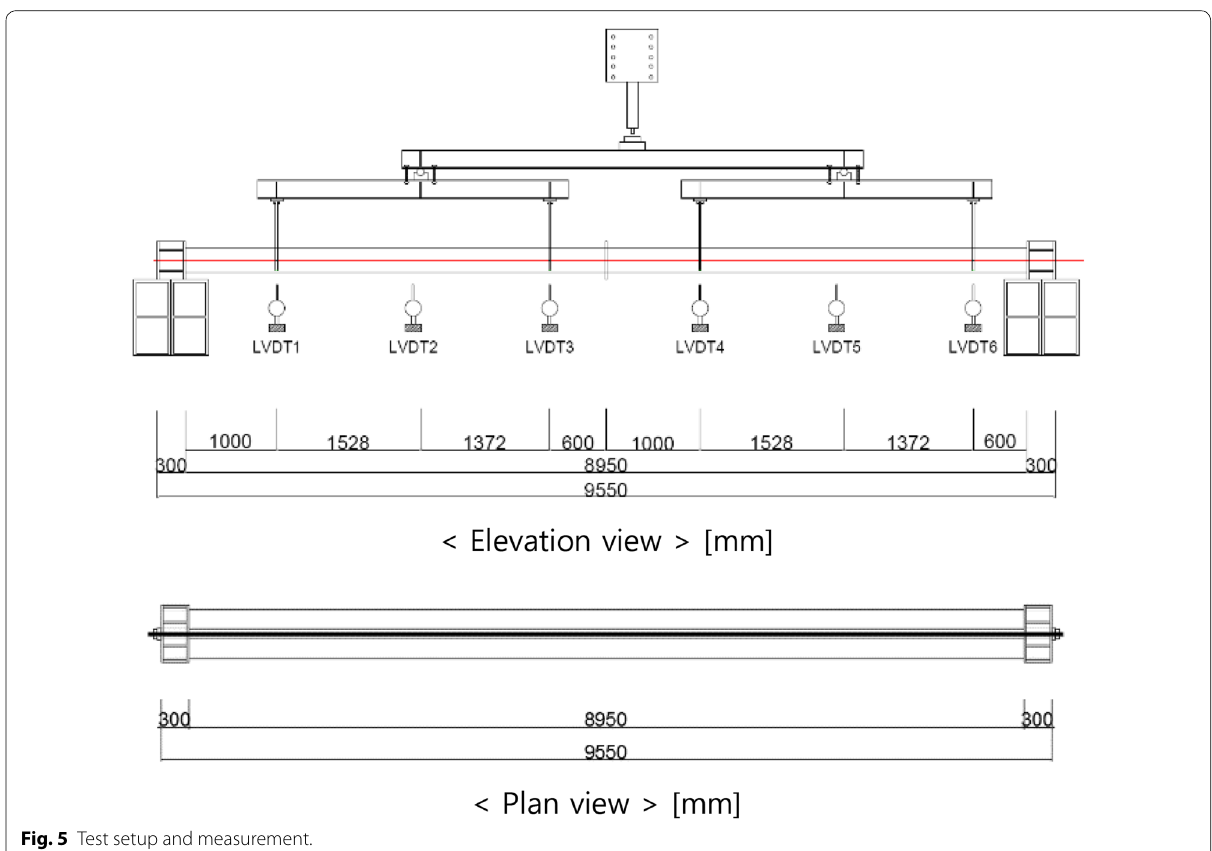
Fig. 5 Test setup and measurement.